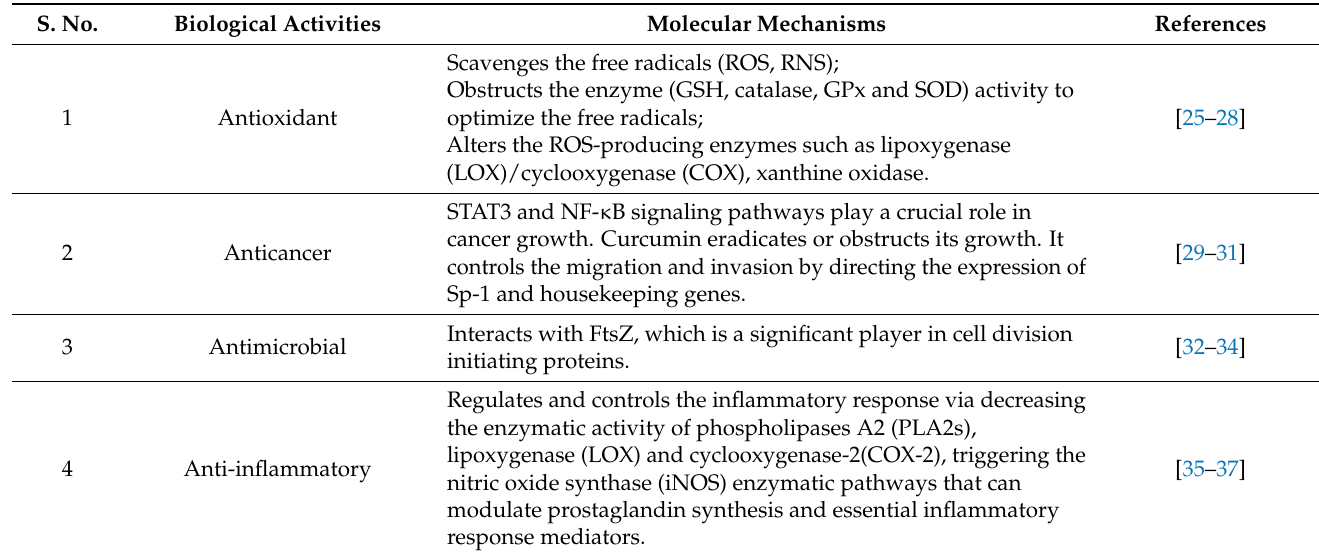
Figure 3. Overall applications of curcumin. Image depicts various biological applications of curcumin irrespective to its bioavailability. Table 2. Biological activities and their molecular mechanisms of curcumin.